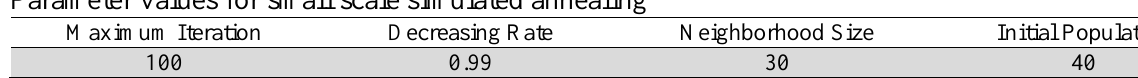
Parameter values for large scale genetic algorithm Maximum Iteration Parameter values for small scale simulated annealing Maximum Iteration